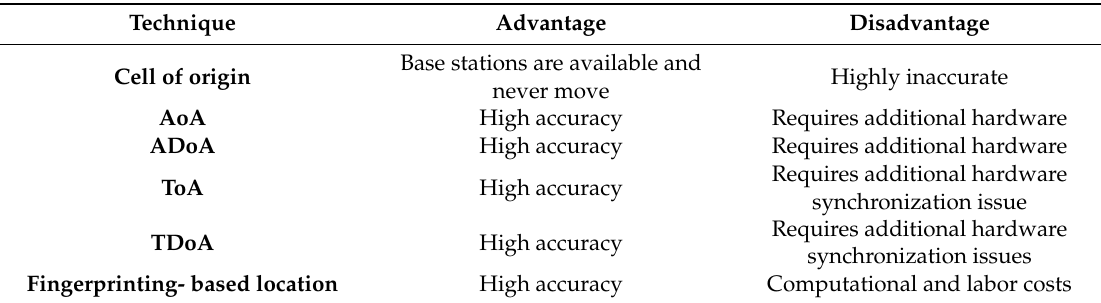
Table 1. RF Position Techniques